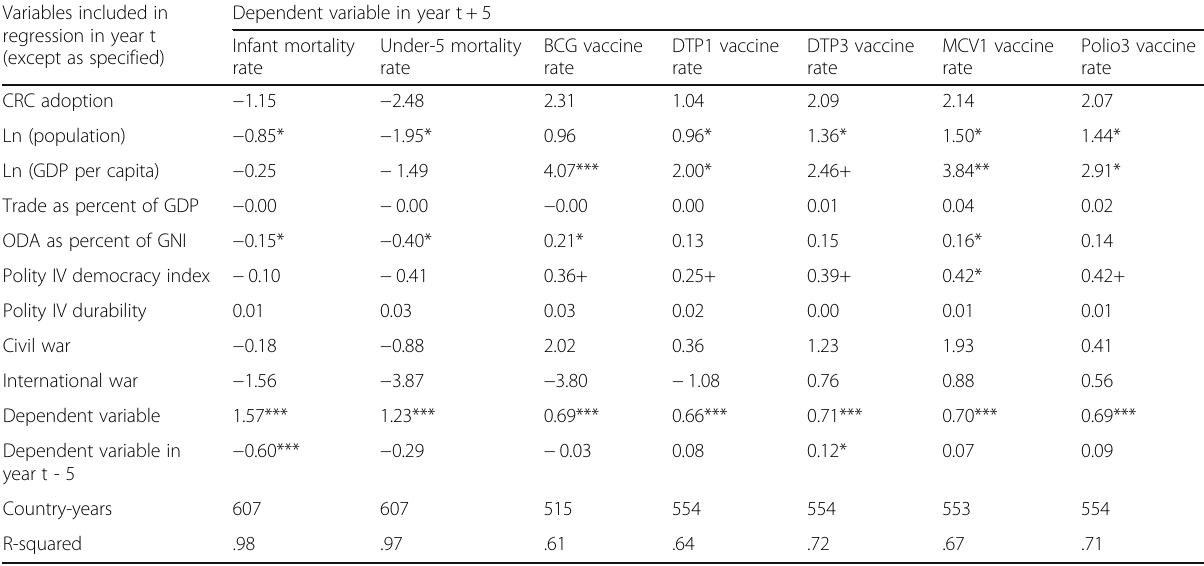
Table 4 Year fixed effect regression estimates of relationship between CRC adoption and child mortality and vaccination rates Variables included in regression in year t (except as specified)